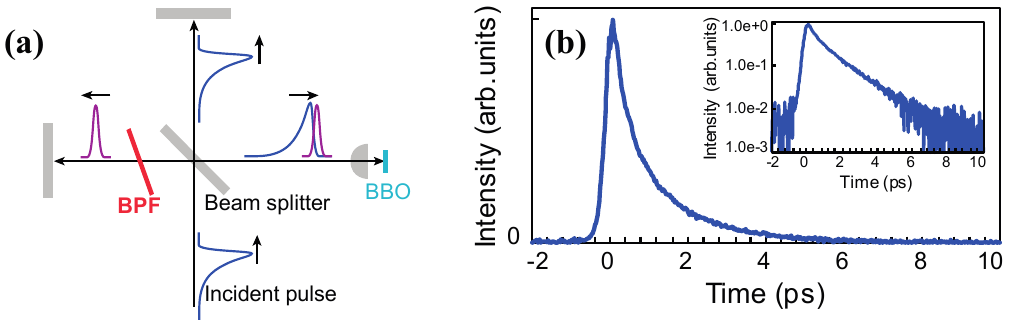
Figure 3. ( a ) Schematic representation of cross-correlation measurement. BPF: Bandpass filter, BBO: β -BaB 2 O 4 crystal; ( b ) Cross-correlation measurement trace. Inset: Cross-correlation trace in logarithmic intensity